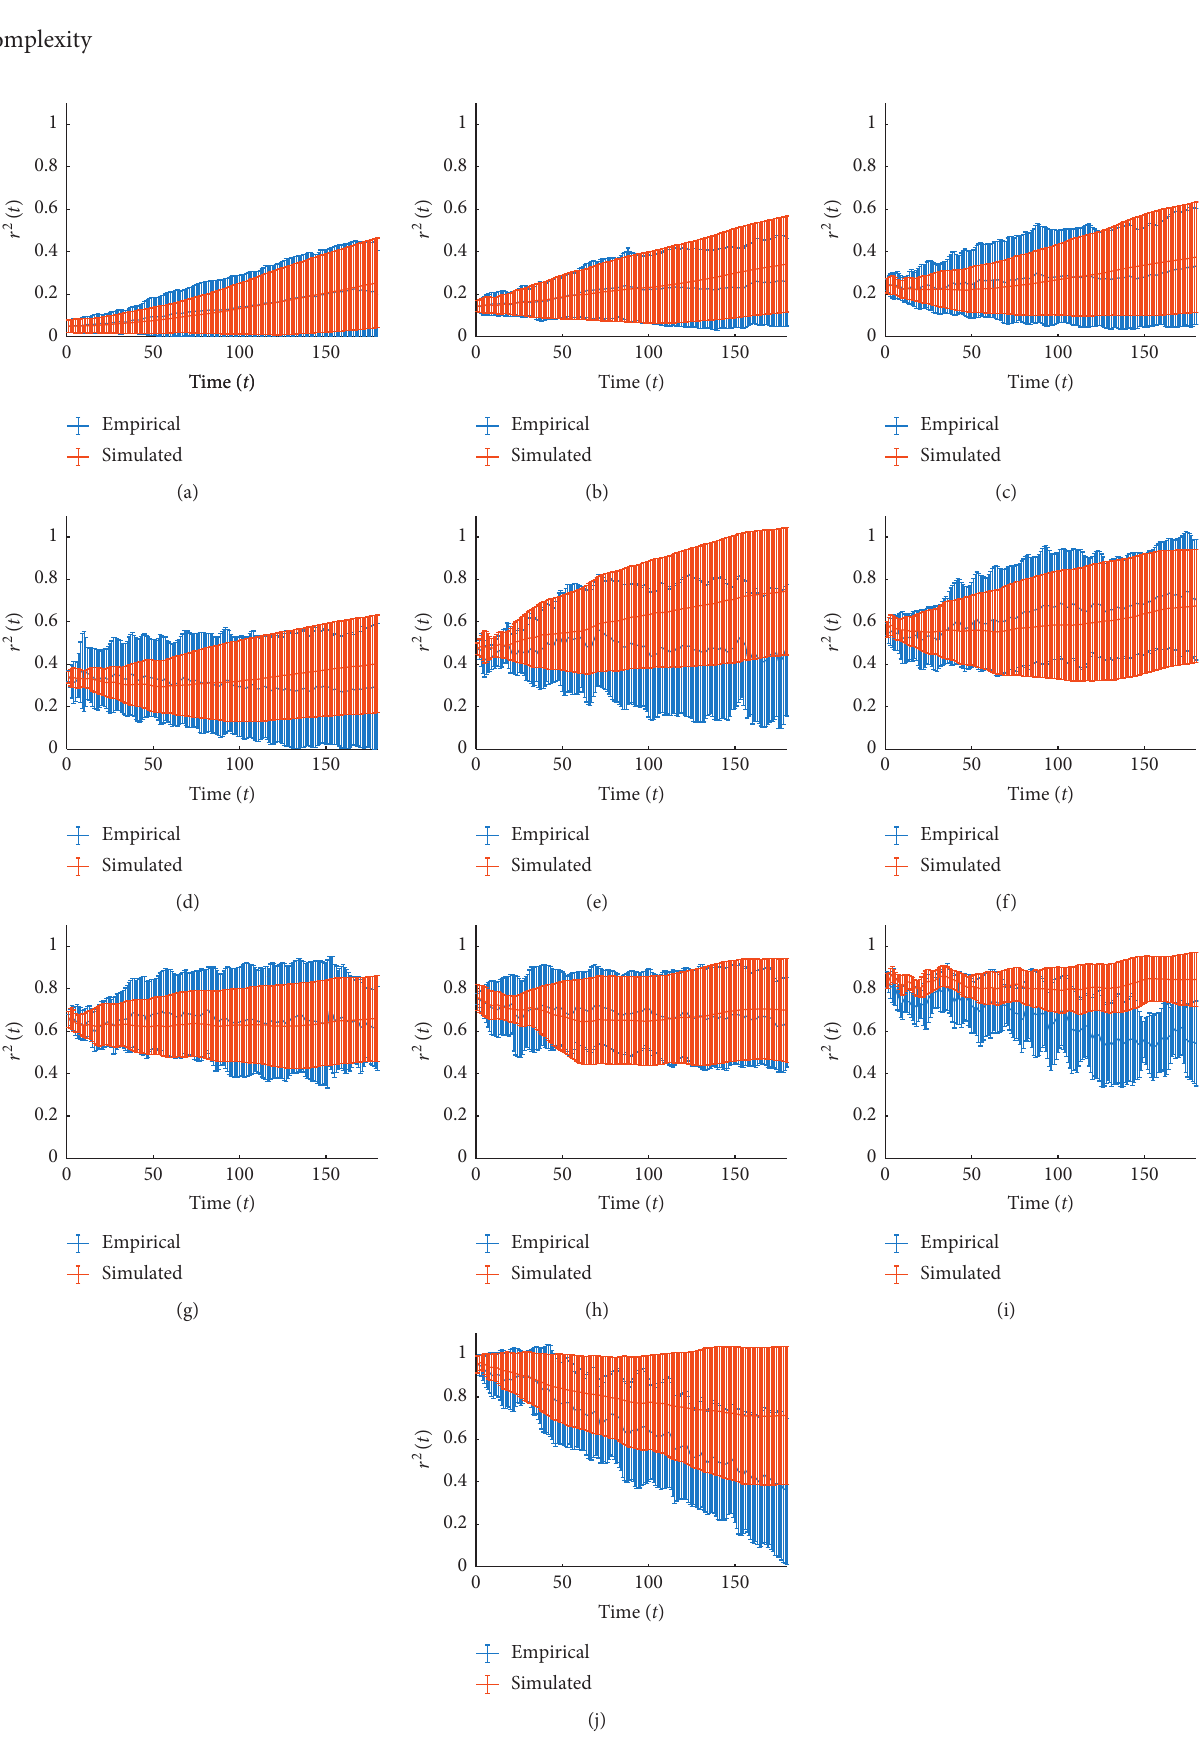
Figure 4: Plot of empirical and simulated trajectories. Each graph is selectively aggregated based on the initial r 2 of the trajectories from [ 0 . 0 , 0 . 1 ) to [ 0 . 9 , 1 . 0 ] . The statistical similarity between the empirical and simulated trajectories is tabulated in Table 2. (a) Initial r 2 ∈ [ 0 . 0 , 0 . 1 ) . (b) Initial r 2 ∈ [ 0 . 1 , 0 . 2 ) . (c) Initial r 2 ∈ [ 0 . 2 , 0 . 3 ) . (d) Initial r 2 ∈ [ 0 . 3 , 0 . 4 ) . (e) Initial r 2 ∈ [ 0 . 4 , 0 . 5 ) . (f) Initial r 2 ∈ [ 0 . 5 , 0 . 6 ) . (g) Initial r 2 ∈ [ 0 . 6 , 0 . 7 ) . (h) Initial r 2 ∈ [ 0 . 7 , 0 . 8 ) . (i) Initial r 2 ∈ [ 0 . 8 , 0 . 9 ) . (j) Initial r 2 ∈ [ 0 . 9 , 1 . 0 )